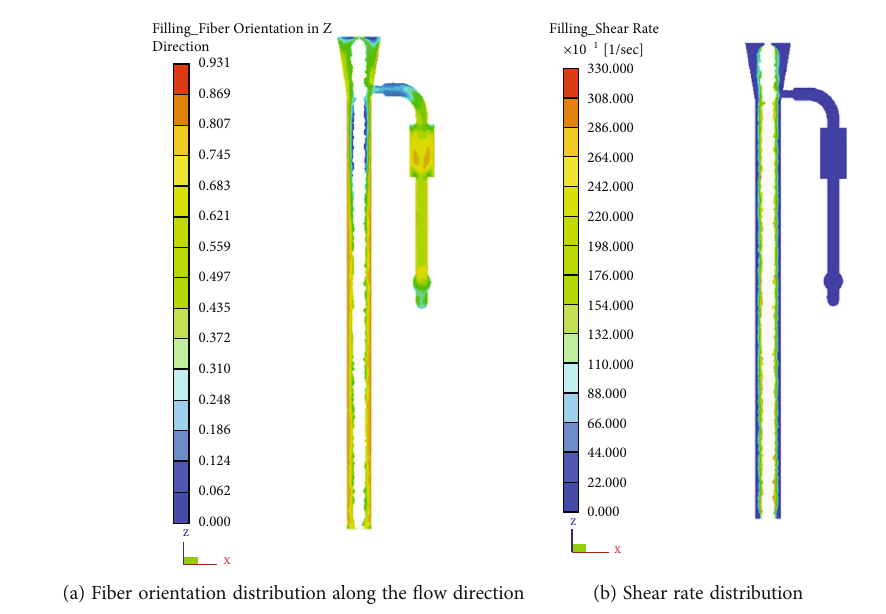
Figure 9: Distribution of fi ber orientation and melt shear rate at a water injection pressure of 9MPa.